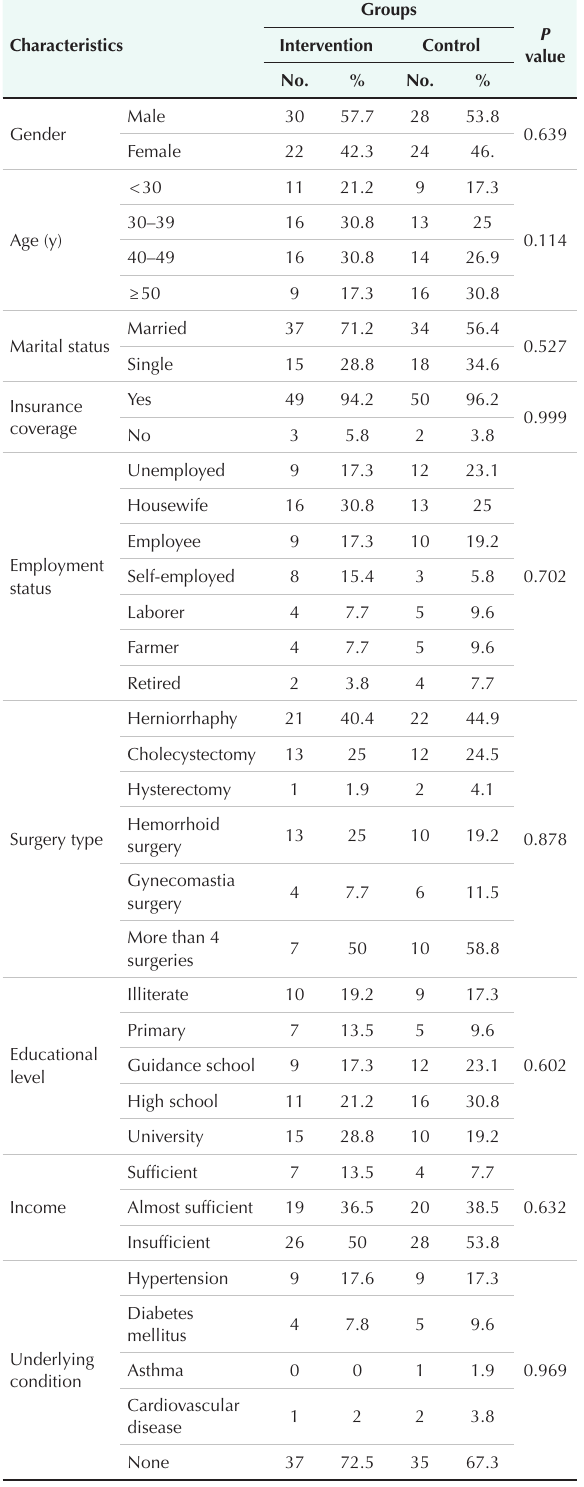
Table 2 . The pretest and posttest levels of state and trait anxiety in the study groups Groups Group Anxiety Before